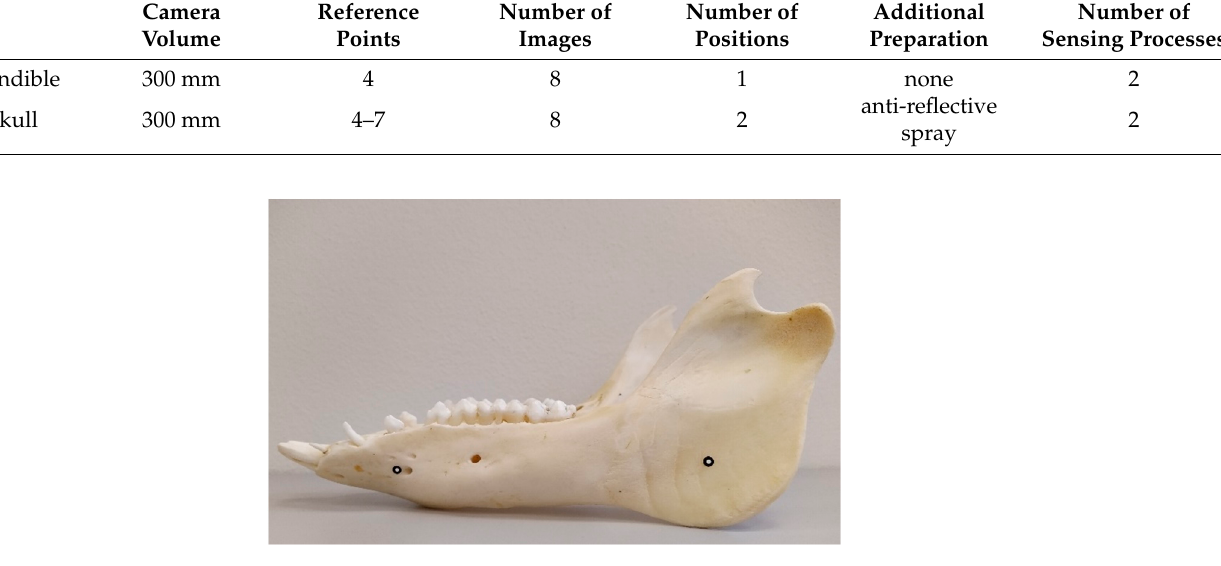
Figure 1. Location of reference points on the mandible of a wild boar ( Sus scrofa )—left side, the same location on the opposite side because of the rotation and manipulation of the object.